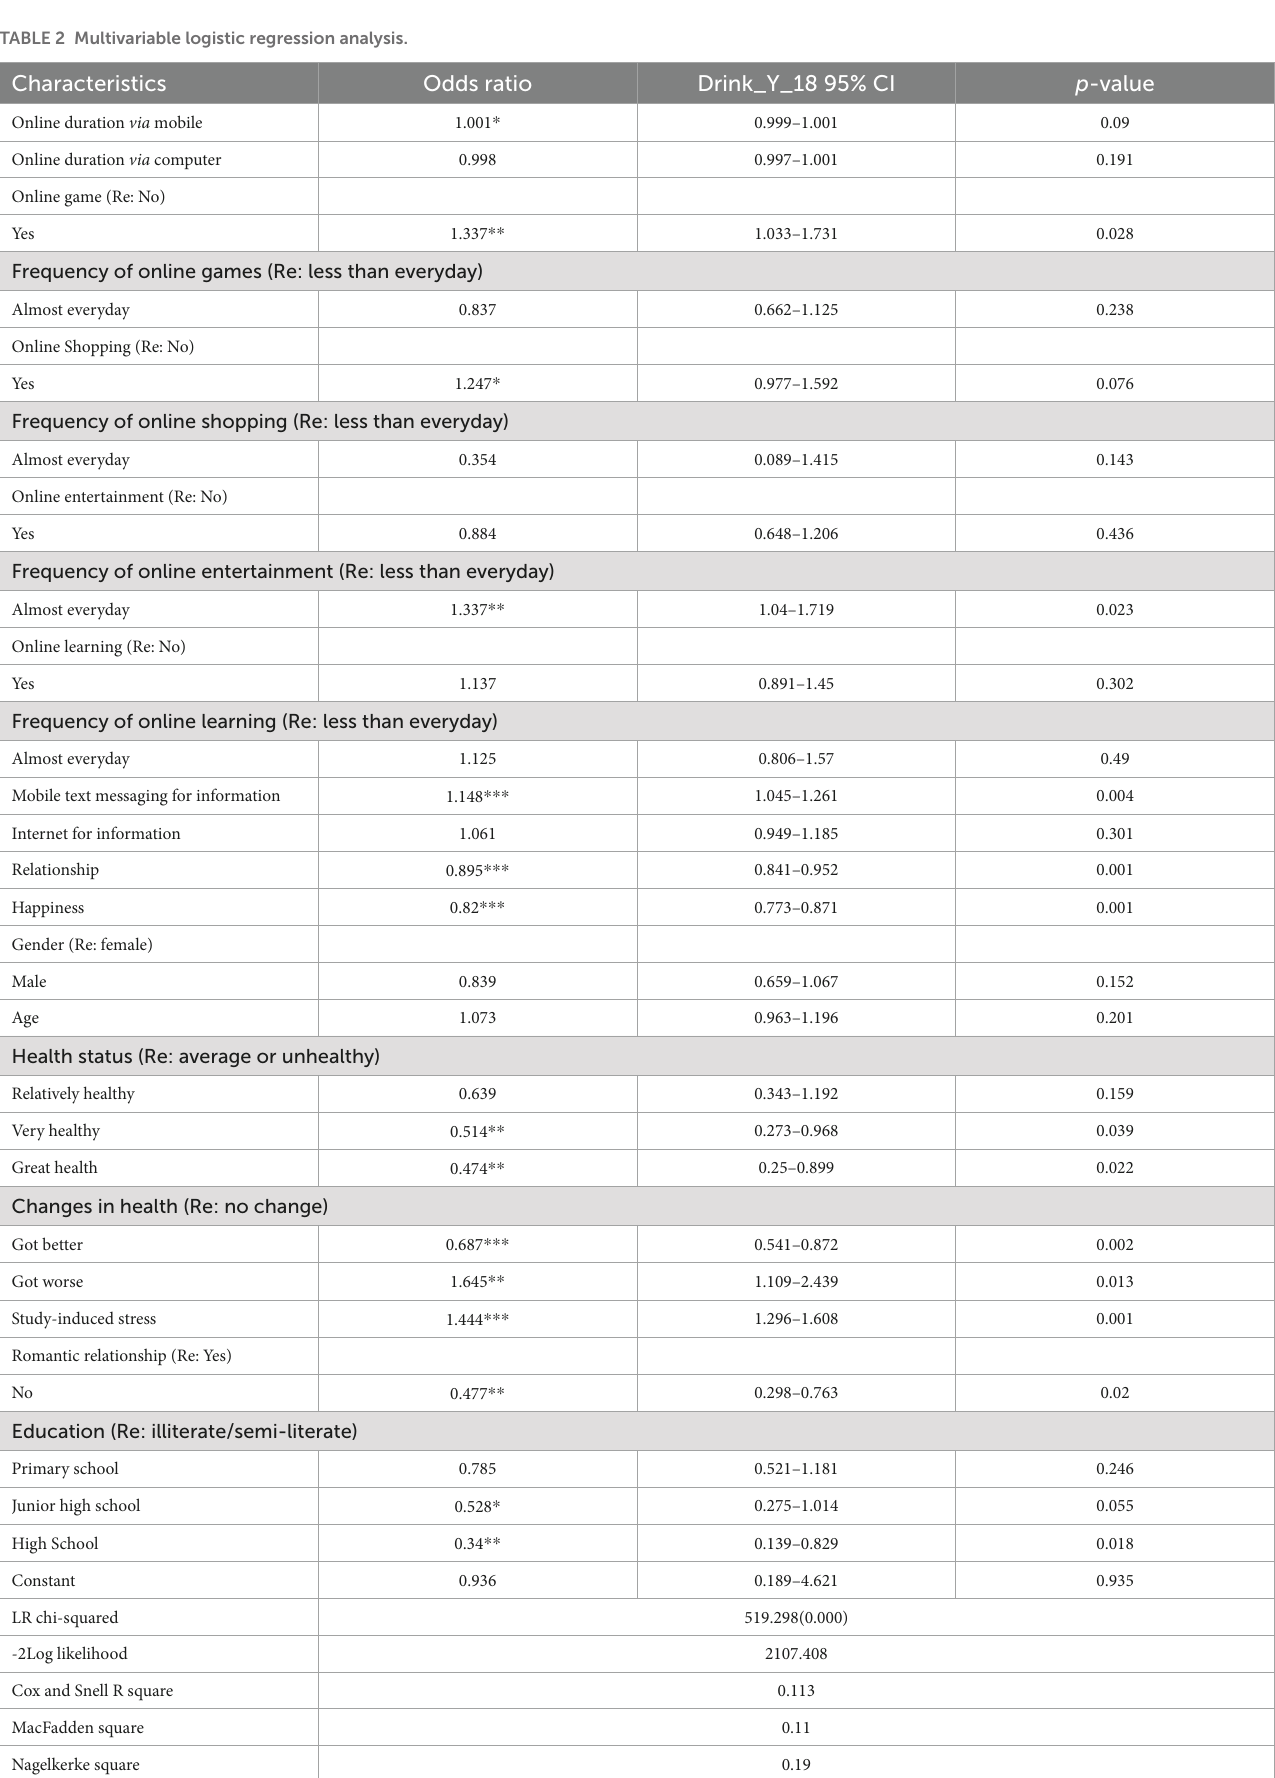
TABLE 2 Multivariable logistic regression